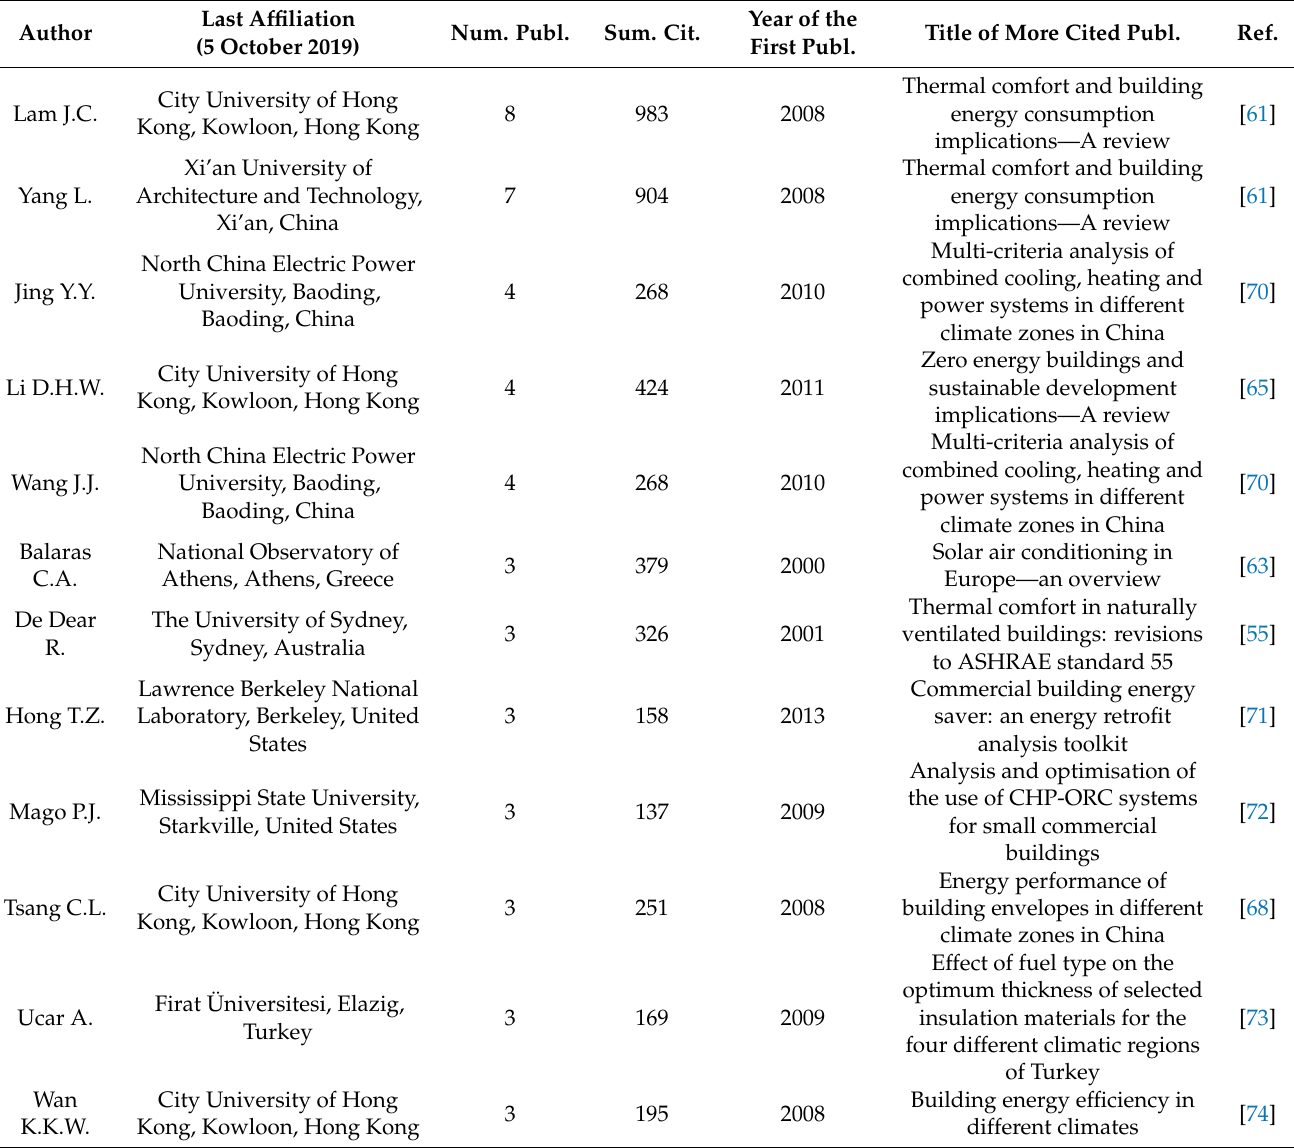
Table 2. Principal authors of the analysed